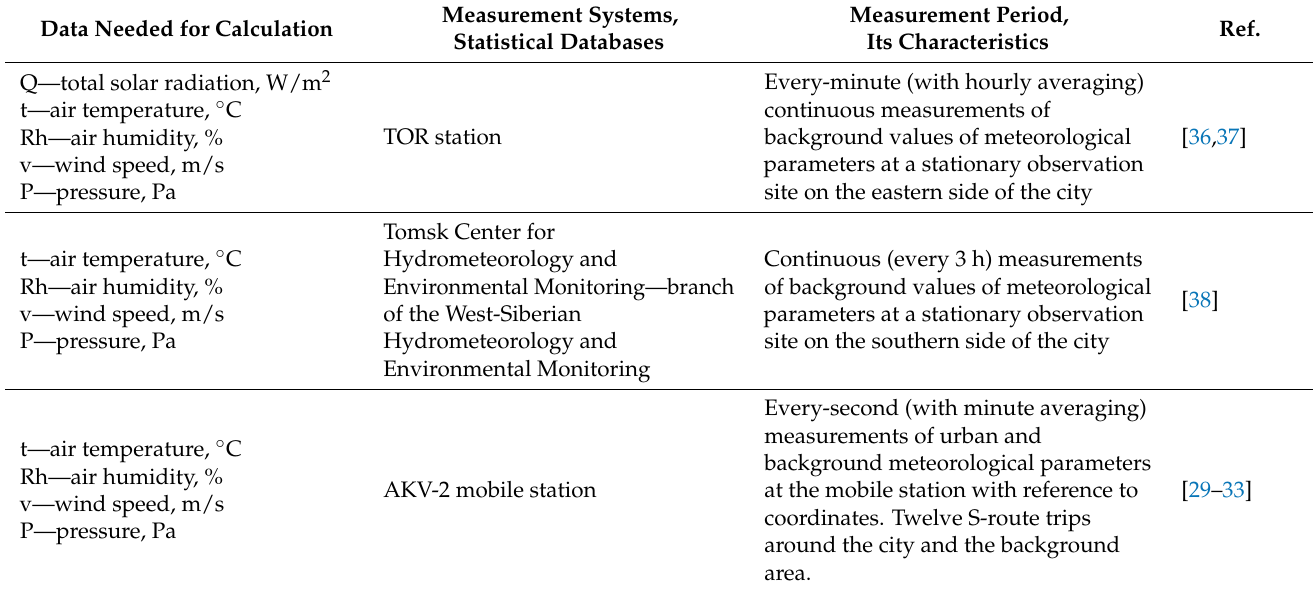
Table 1. Data needed to calculate the components of additional heat influx temperature increment in the city, measurement systems, and measurement